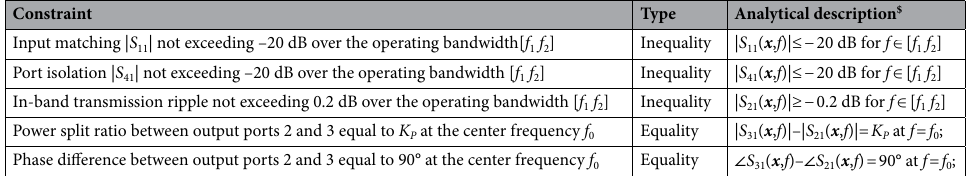
Table 1. Example constraints in size-reduction of microwave components. $ The symbol | S jk ( x , f )| stands for the modulus of the S -parameter S jk at the design x , and frequency f